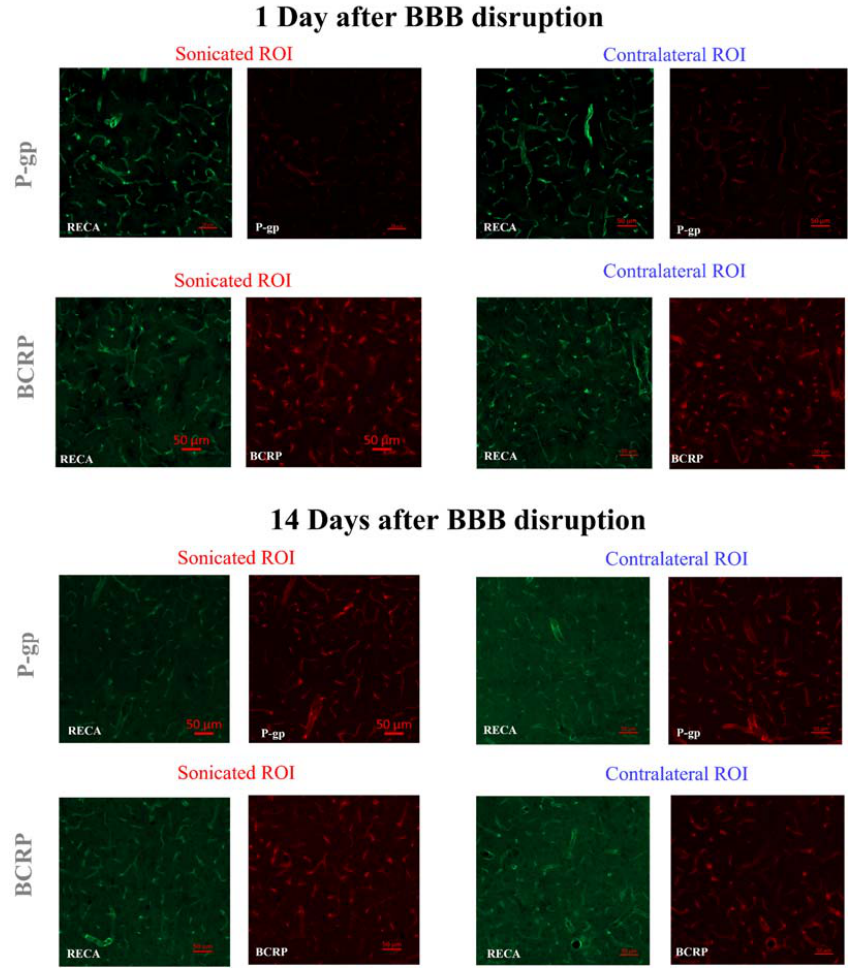
Figure 1. Representative immunohistochemical staining of P ‐ gp and BCRP on sonicated and contralateral brain tissues, obtained on day 1 and 14 days after FUS ‐ induced BBB disruption.